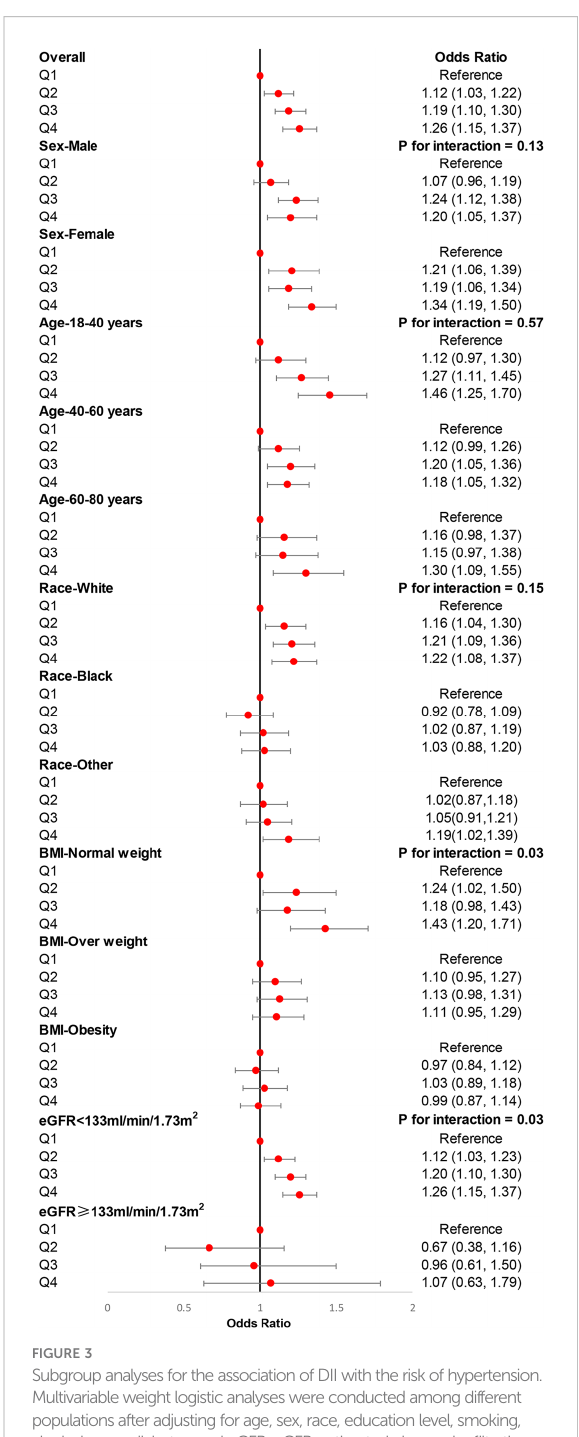
FIGURE 3 SubgroupanalysesfortheassociationofDIIwiththeriskofhypertension. Multivariableweightlogisticanalyseswereconductedamongdifferent populationsafteradjustingforage,sex,race,educationlevel,smoking, alcoholusers,diabetes,andeGFR.eGFR,estimatedglomerular fi ltration